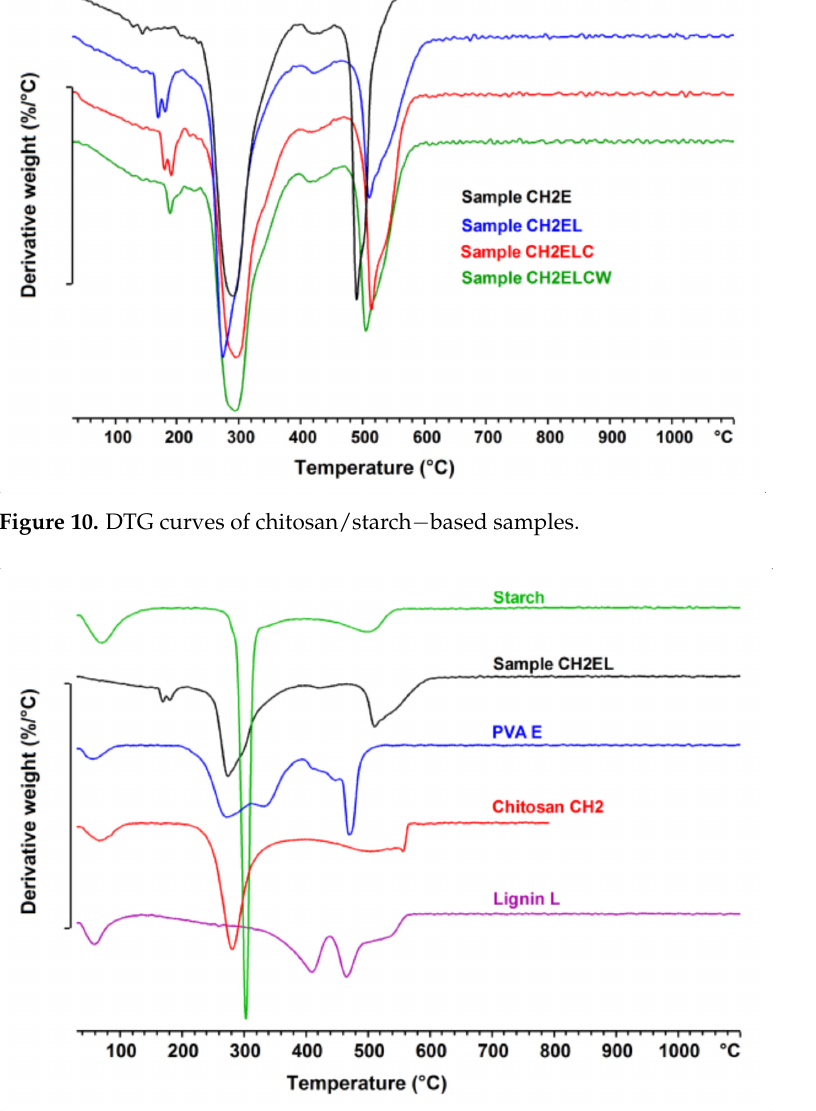
Figure 11. DTG curves of sample CH2EL, pure starch, PVA E, chitosan CH2 and lignin